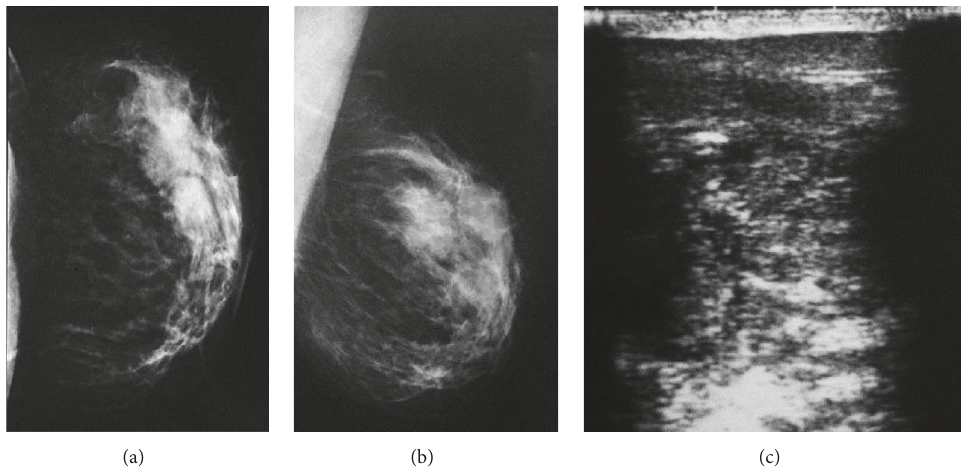
Figure 2: Mammogram images (a and b) showing a mass with irregular posterior limits, which on ultrasound image (c) is a hypoechoic mass with irregular and indistinct margins at the 2 o’clock position of the left breast measuring approximately 4.2 cm in maximal diameter (Collection of the Department of Radiology, University Teaching Hospital of Lom´e) .